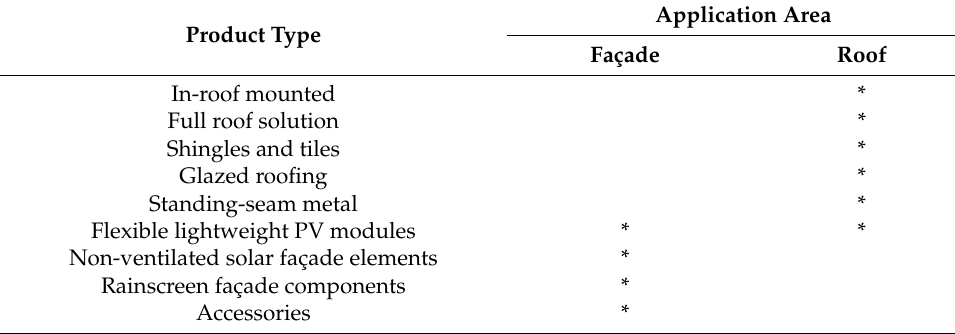
Table 1. Products of the BIPV systems depending on the application area. Application Area Product Type Façade Roof In-roof mounted * Full roof solution * Shingles and tiles * Glazed roofing * Standing-seam metal * Flexible lightweight PV modules * * Non-ventilated solar façade